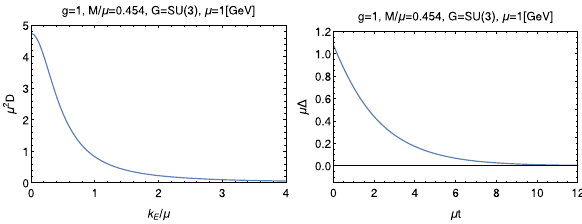
Fig. 9 The same plots as those given in Fig. 7 for a further smaller coupling constant g = 1 with a physical value M /μ = 0 .